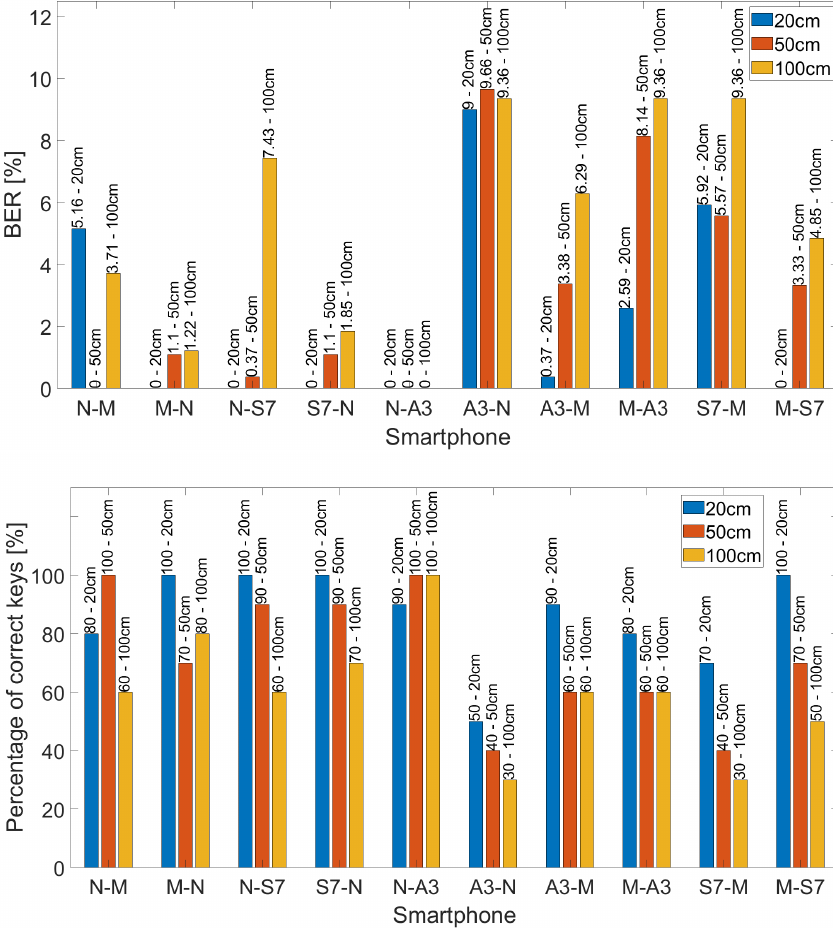
Figure 12. The BER ( up ) and the percentage of correct keys ( down ) for each smartphone